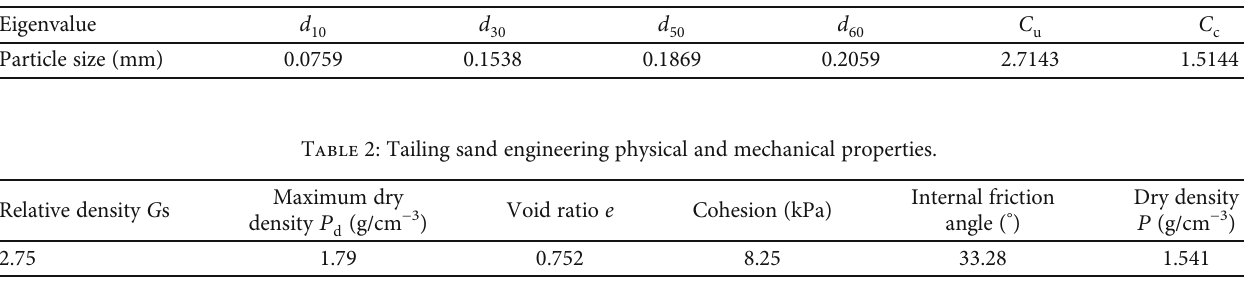
Figure 1: Tail sand sample particle composition curve. Table 1: Tailings particle size characteristics.